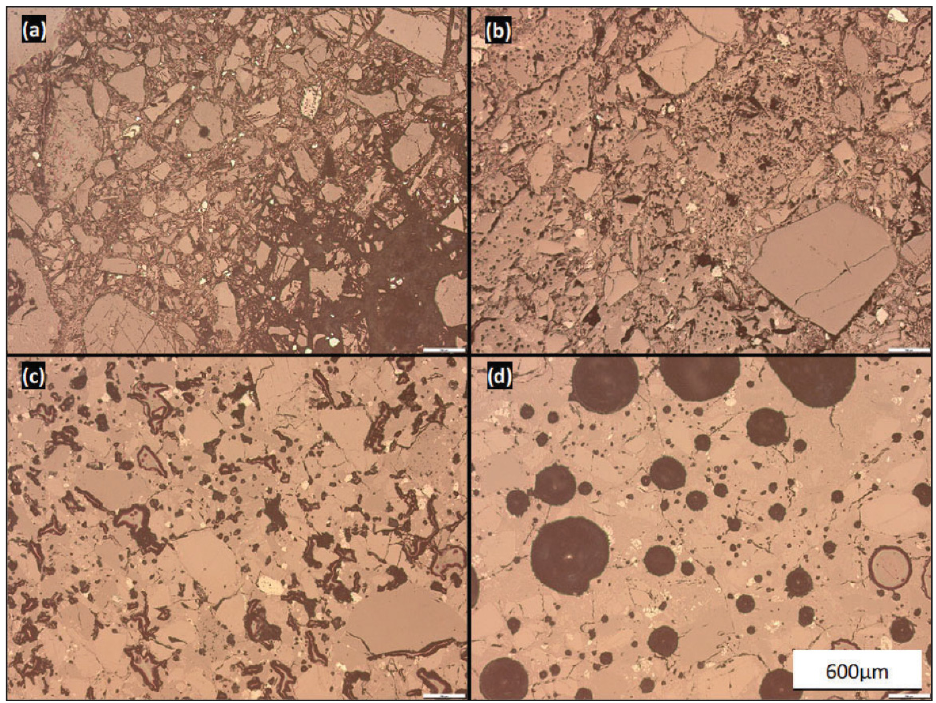
Figure 2. Micrographs of: ( a ) unsintered feed material, and sample cross-sections sintered for 2 h at: ( b ) 1100 °C, ( c ) 1150 °C, and ( d ) 1200 °C.